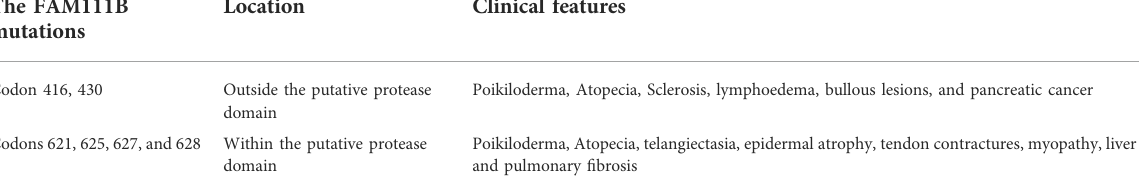
TABLE 1 A comparison of clinical features of different mutation spots of FAM111B. The FAM111B